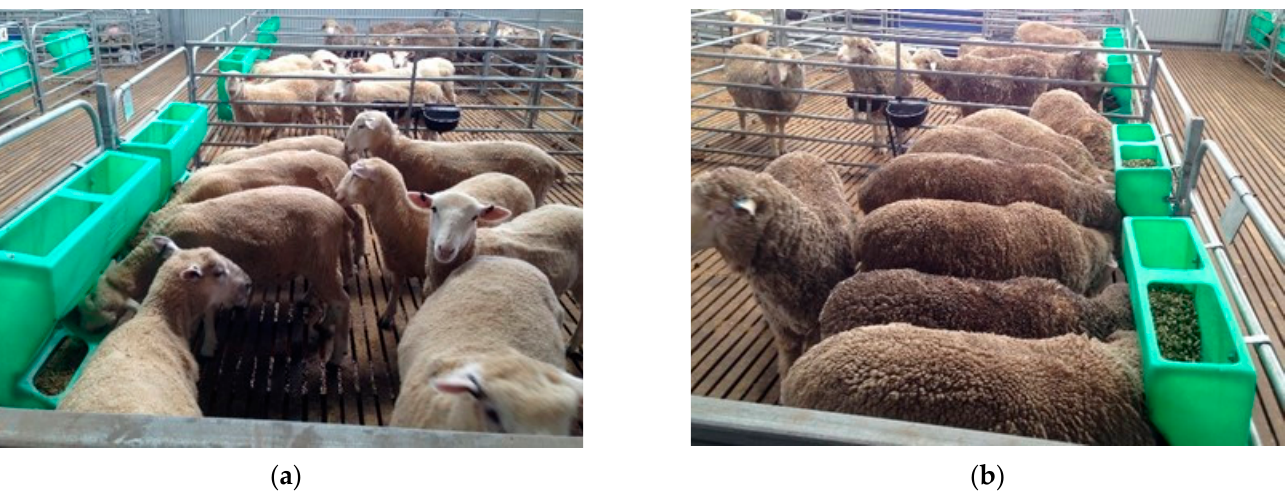
Figure 6. Maternal Composite lambs ( a ) and Merino yearlings ( b ) used in the feeding experiment. There were 7 pens of Composite lambs (8 animals/pen) and 7 pens of Merino yearlings (8 ani- mals/pen) used for the feed intake and liveweight gain measures.